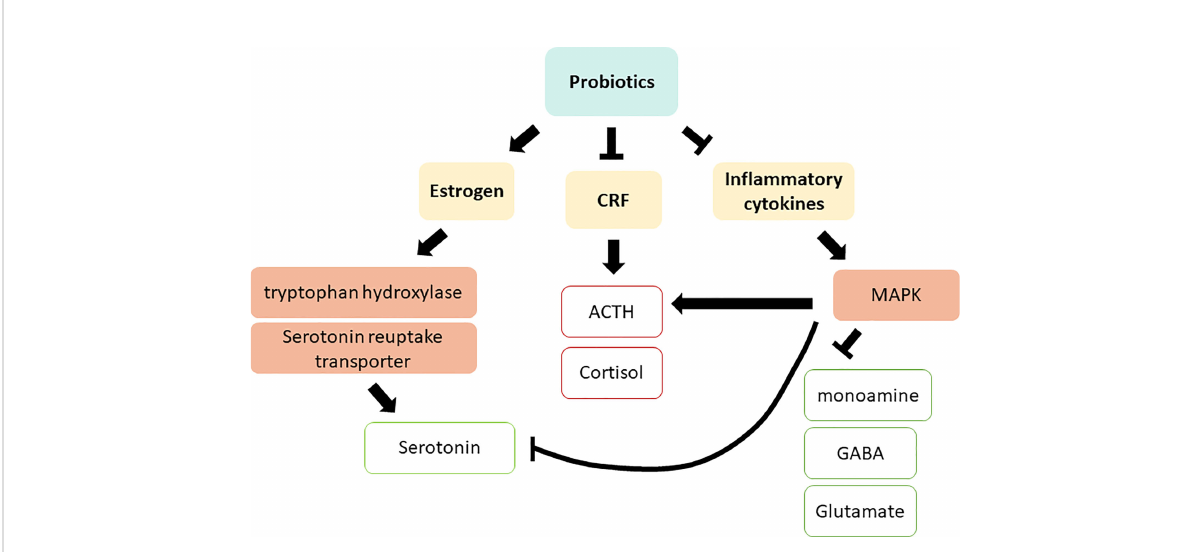
FIGURE 4 Action mechanisms of probiotics on depression via regulating systemic biomarkers. CRF, Corticotropin releasing factor; ACTH, adrenocorticotropic hormone; MAPK, MAP kinase; GABA, g -Aminobutyric acid. Red squares indicate an increased level in depressive patients; green squares indicate a decreased level in depressive